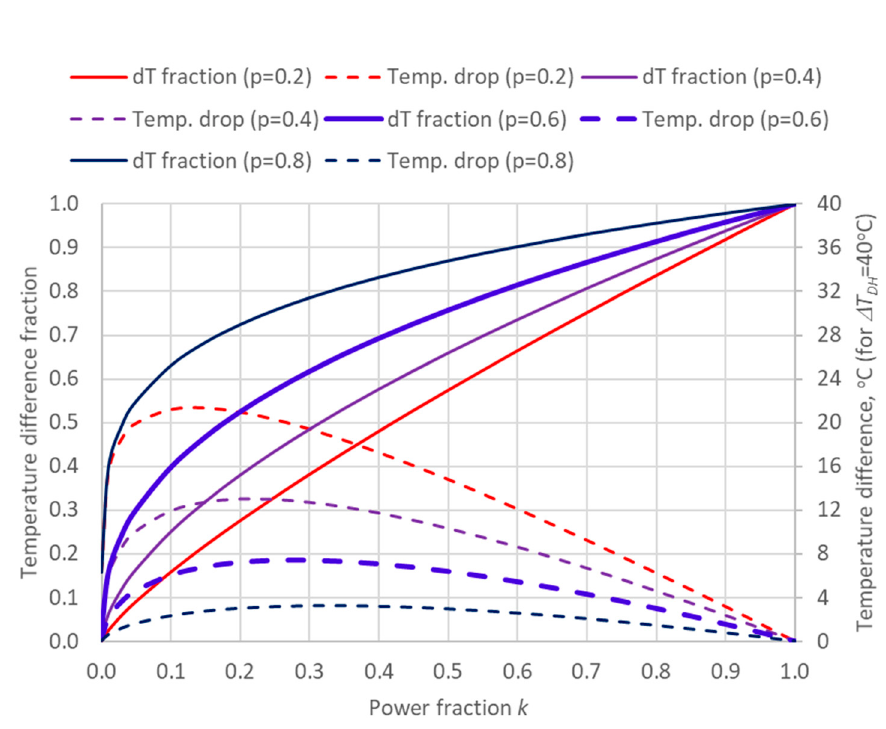
Figure 8. Temperature difference (dT) fraction Δ T HPC / Δ T DH and temperature drop fraction after HP junction ( Δ T DH,S / Δ T DH ).